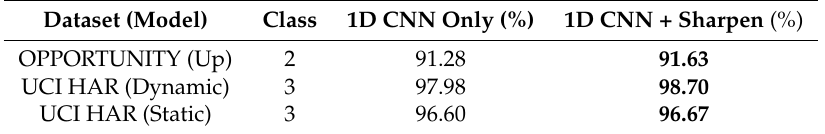
Table 8. Comparison of activity recognition accuracy without (1D CNN only) and with test data sharpening (1D CNN+Sharpen). The bold numbers indicate the highest accuracy for each